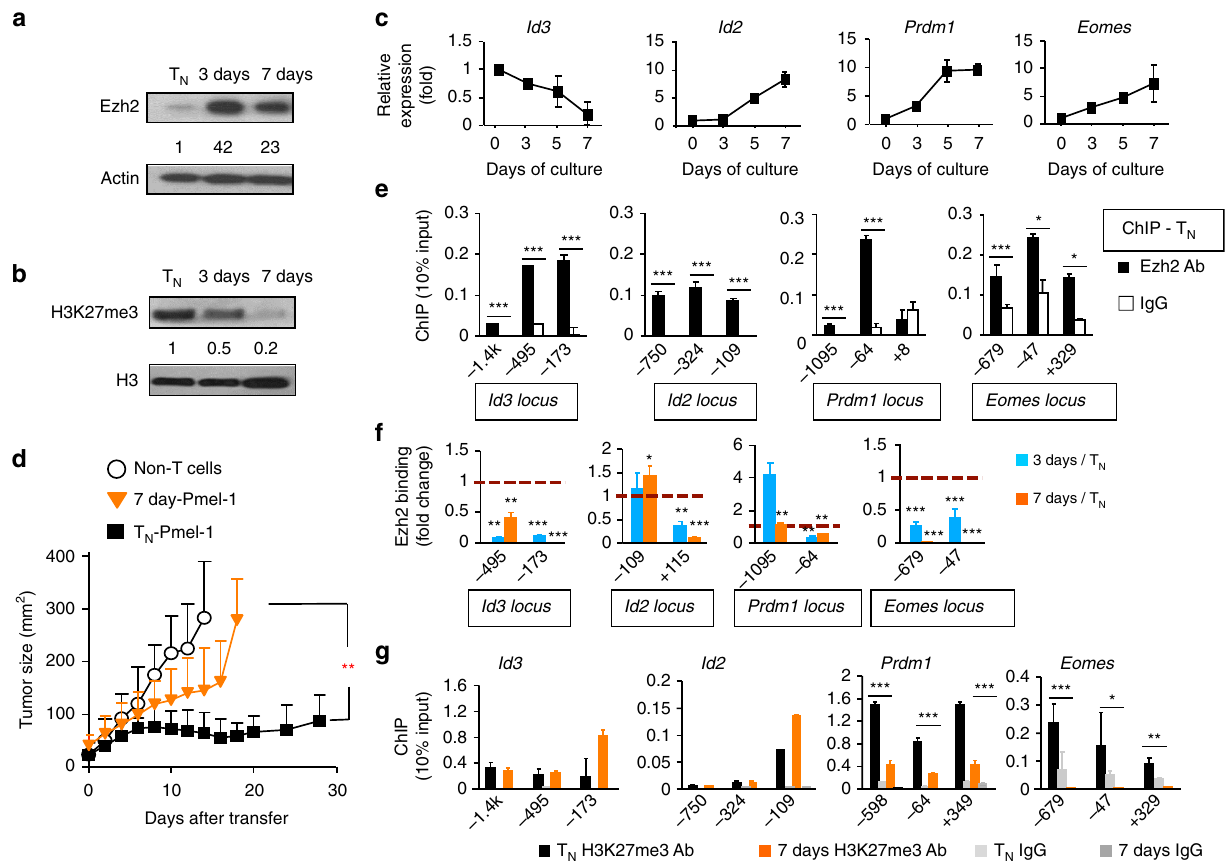
Fig. 4 Ezh2 is dissociated from the regulatory regions of key TFs during CD8 + T-cell expansion. WT naive Pmel-1 cells were stimulated with anti-CD3/ CD28 Ab + IL-2 for 7 days. Cells were collected at 0 days, 3 days and 7 days. a , b Immunoblot analysis of Pmel-1 cells before and after TCR-activation, probed with anti-Ezh2 Ab ( a ) and anti-H3K27me3 Ab ( b ). c Real-time RT-PCR analysis of gene expression in Pmel-1 cells before and after activation at indicated time points. d Tumor size in B16 tumor-bearing B6 mice receiving no transfer (Non-T cells), transfer of WT naive Pmel-1 cells (T N ) or in vitro TCR-activated 7 days Pmel-1 cells and treatment with IL-2 and gp100-DCs for 3 days. e – g ChIP analysis of T N ( e ), 3 days and 7 days Pmel-1 cells ( f ), and T N and 7 days Pmel-1 cells ( g ). * p < 0.05, ** p < 0.01, and *** p < 0.001 (two-tailed unpaired t test). The data are representative of four independent experiments ( a – c ), two experiments with n = 5 mice per group in each ( d ; mean ± SD), or three experiments ( e – g ; mean ±